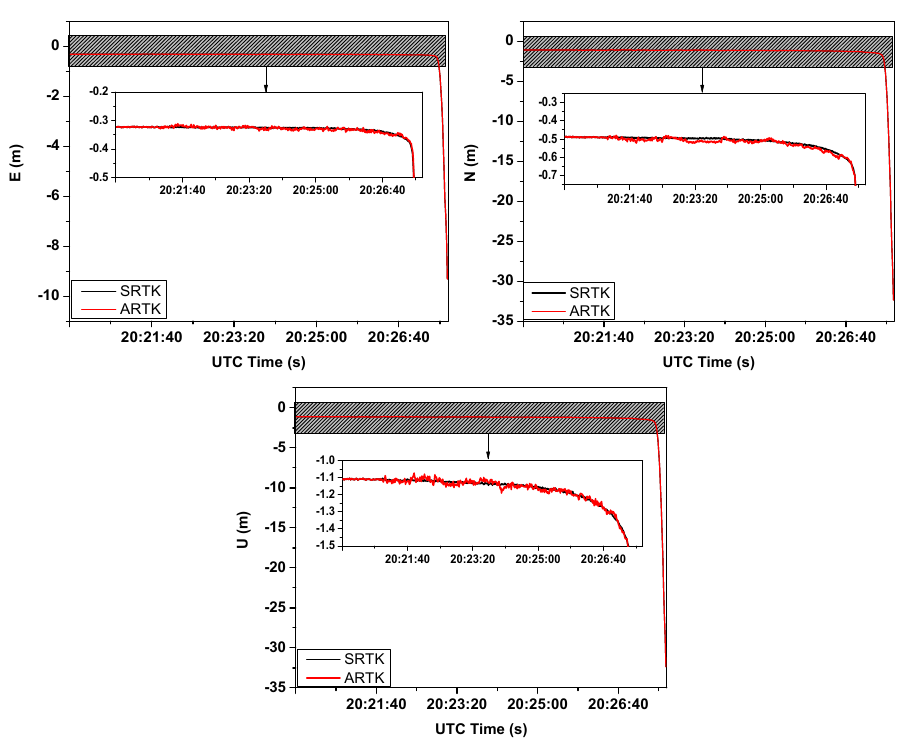
Figure 11. Consistency between the ARTK and SRTK methods in the E, N, and U directions during the final collapse of the landslide monitoring station.